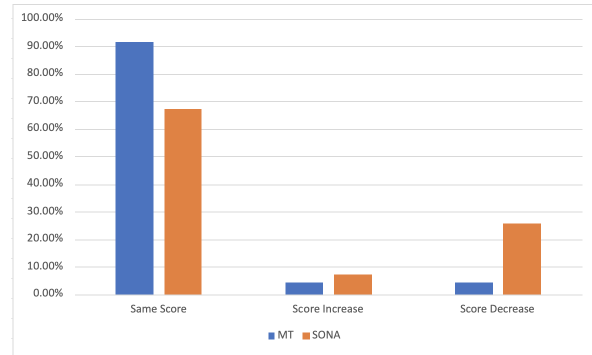
Figure 15. Difference in password strength scores between Part 1 and Part 2 for MTurk and